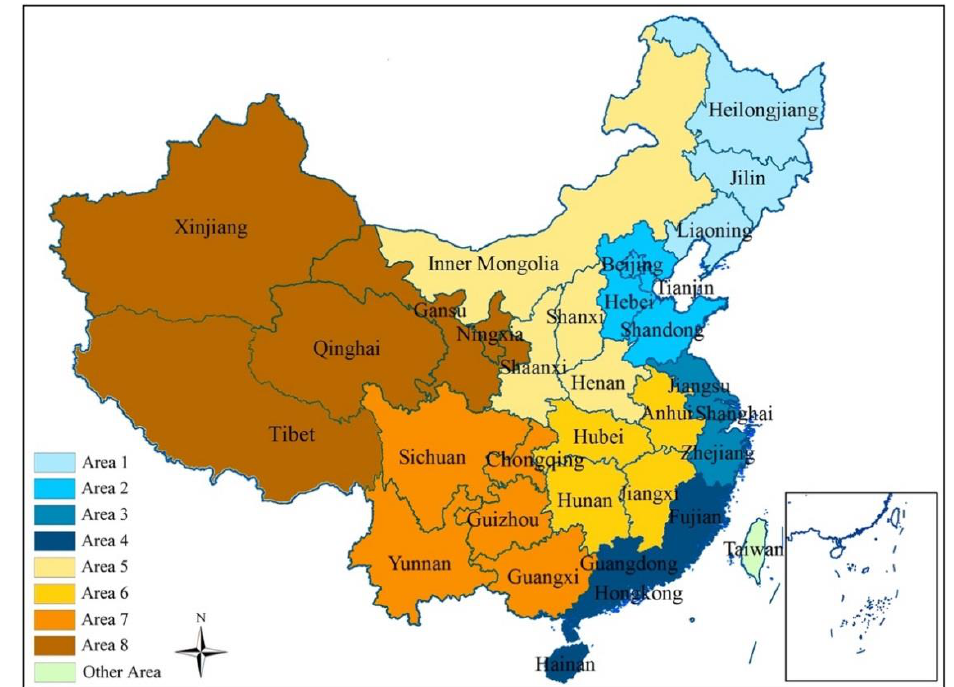
Figure 2. The eight study areas in China.